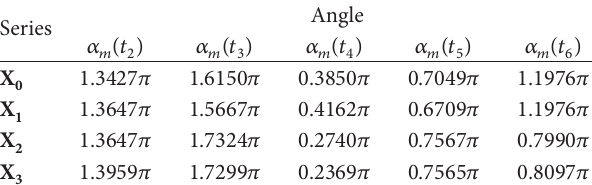
Table 2: The corresponding angle series of the original time series.